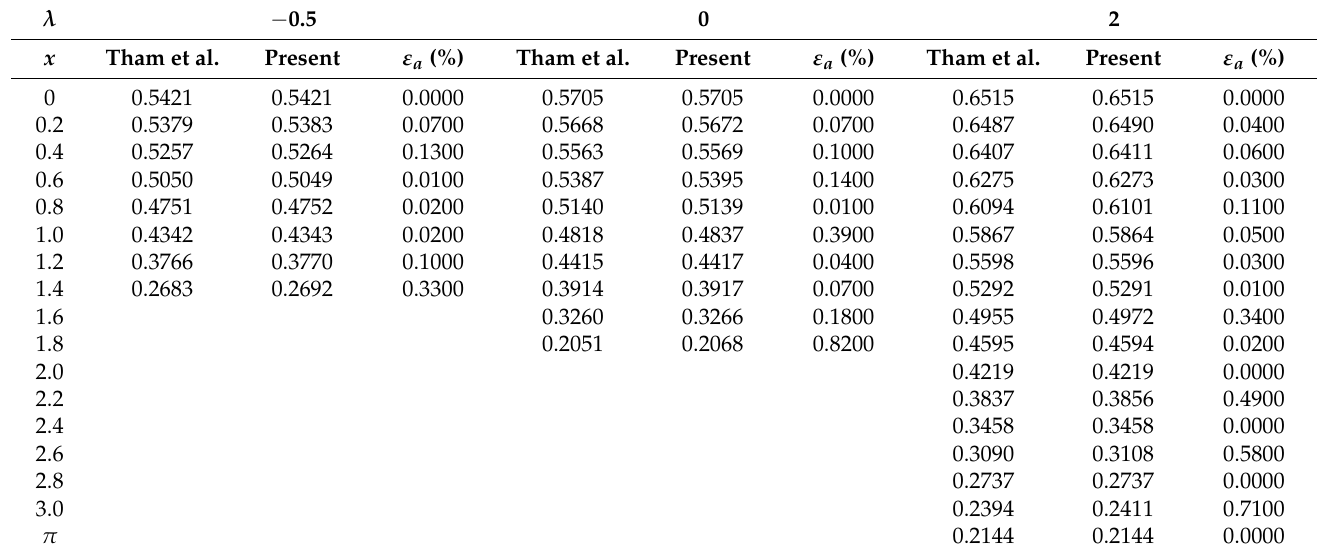
Table 3. Validation of Re − 1/2 Nu by comparing it with Tham’s et al. [70] findings for different values